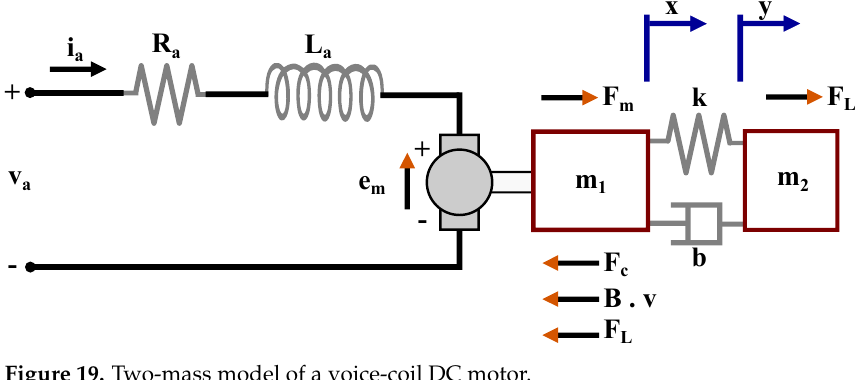
Figure 19. Two-mass model of a voice-coil DC